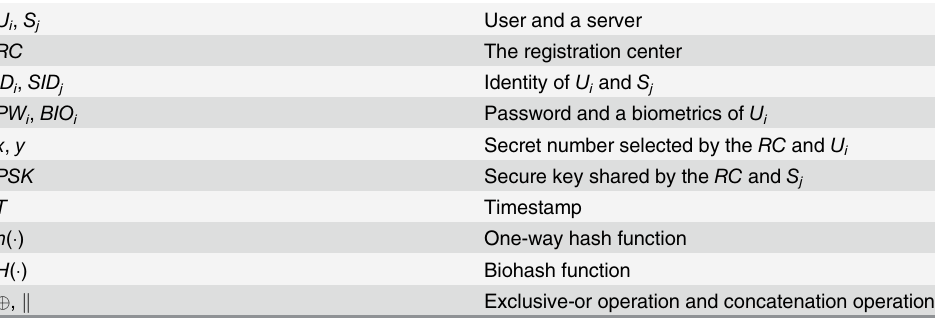
Table 1. Notations used in Lu et al. ’ s